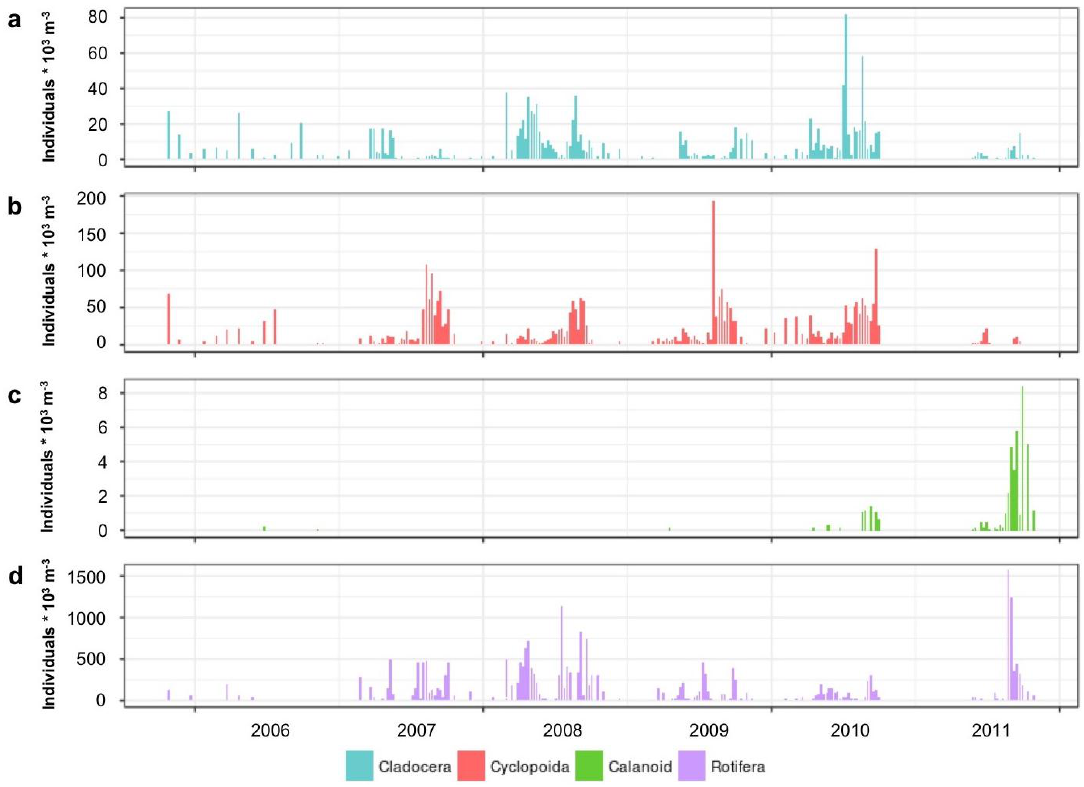
Figure 6. Density of major taxonomic categories of mesozooplankton sampled from Vancouver Lake from October 2005 to October 2011. Abundances are shown for ( a ) cladocerans; ( b ) cyclopoid copepods; ( c ) calanid copepods; and ( d ) rotifers. Data from [62].